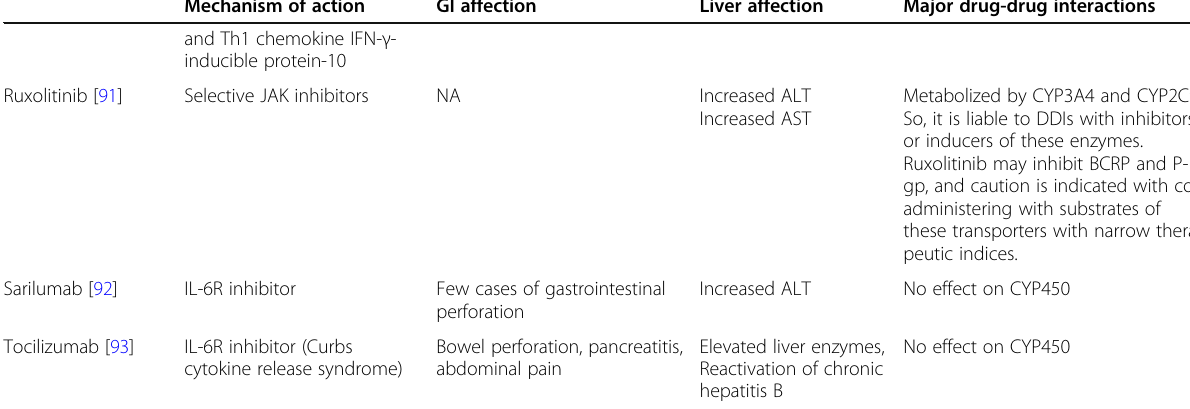
Table 1 Potential GI and liver adverse effects and drug interaction profile of COVID-19 investigational drugs